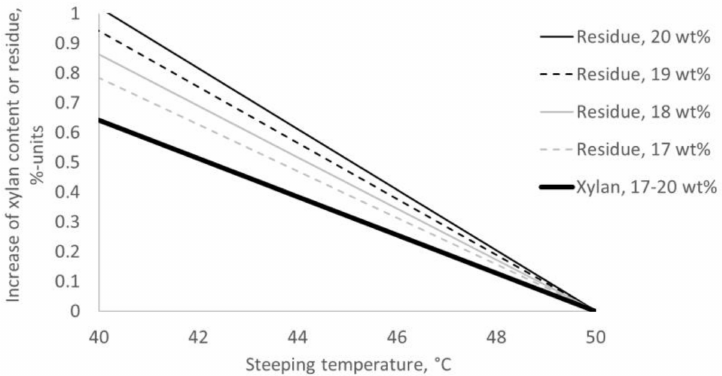
Figure 5. Change in xylan content and residue after extraction of hardwood kraft dissolving pulp with